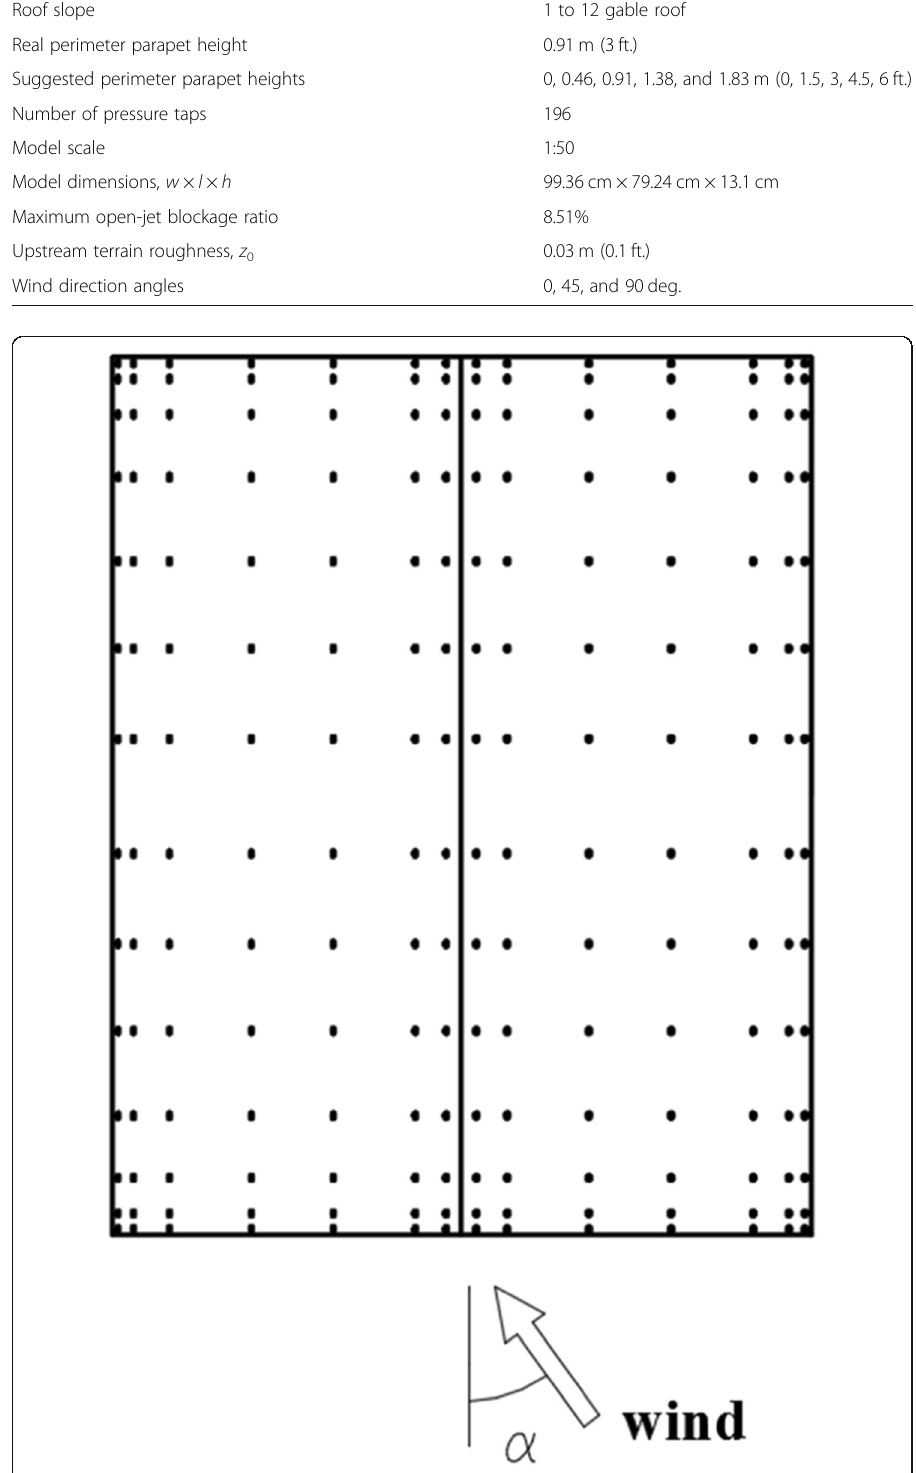
Fig. 6 Location of pressure taps, and definition of wind ’ s angle of